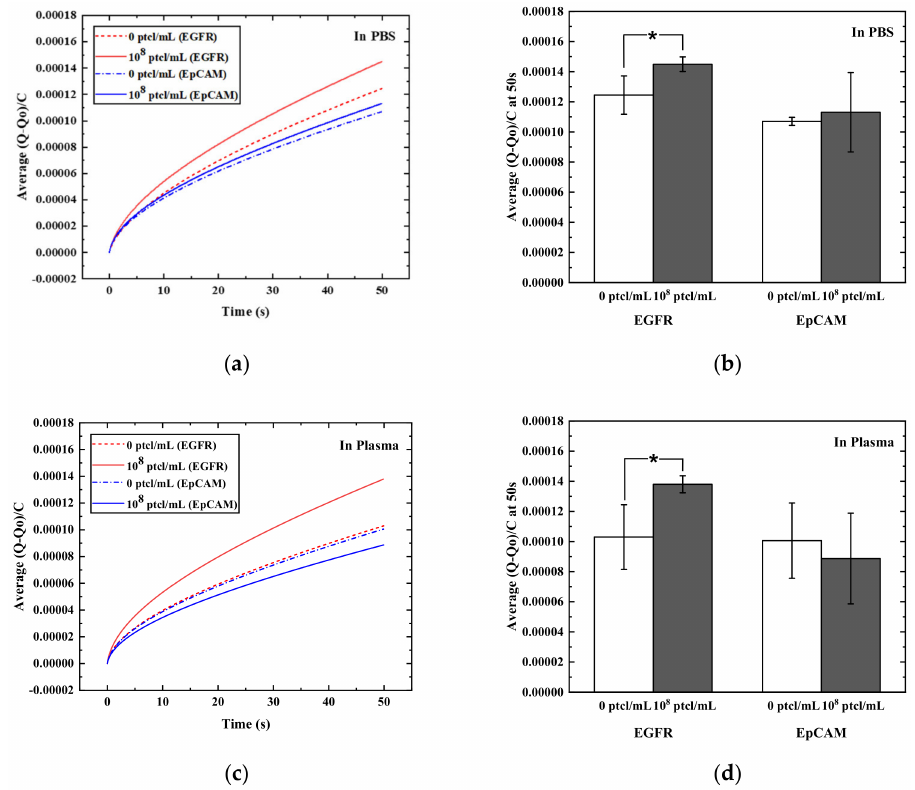
Figure 5. Chronocoulogram recorded (at 0.6 V) ( a , c ) and charge values at 50 s from Figure 5a,c are shown at 50 s after an incubation period of 2 min at immunosensing electrodes treated with different concentrations of EV and different capture antibodies (anti- EGFR or - EpCAM) in PBS ( a , b ) or in 90% of human plasma ( c , d ); Data = mean ± standard deviation, n = 3; * indicates a significant difference ( p ≤ 0.05) between 0 and 10 8 ptcl/mL of EVs with anti-EGFR